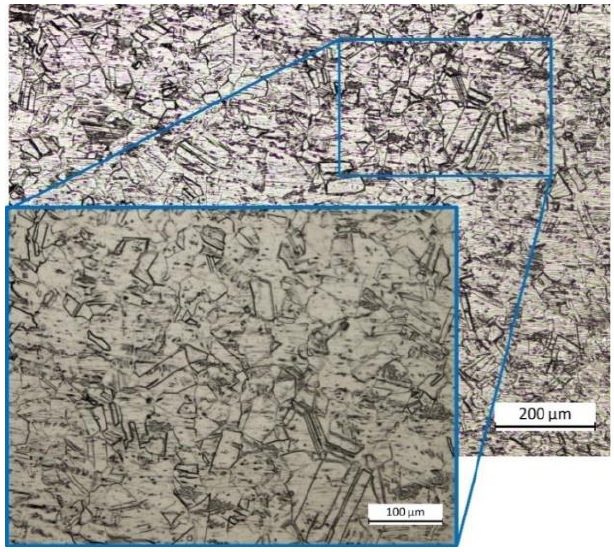
Figure 7. Microstructure of the AISI 316L substrate electrolytically etched in 10% oxalic acid solution for 240 s and 6 V.